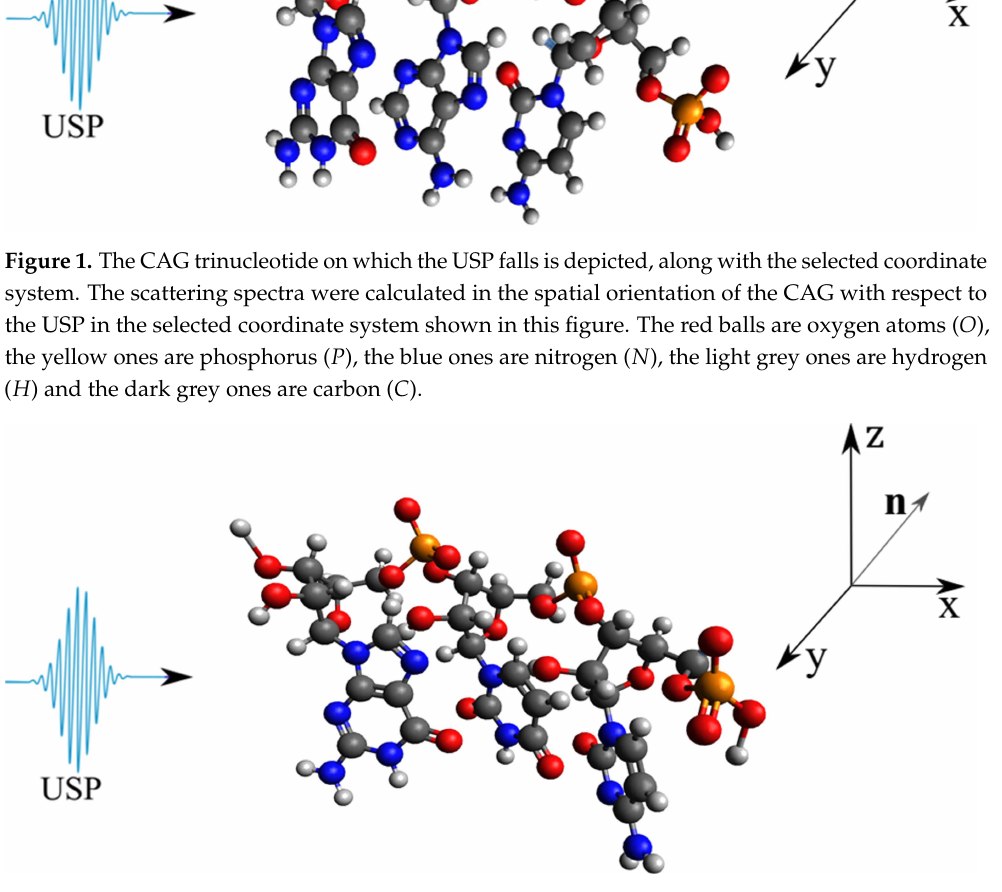
Figure 2. The same as in Figure 1, but only for trinucleide